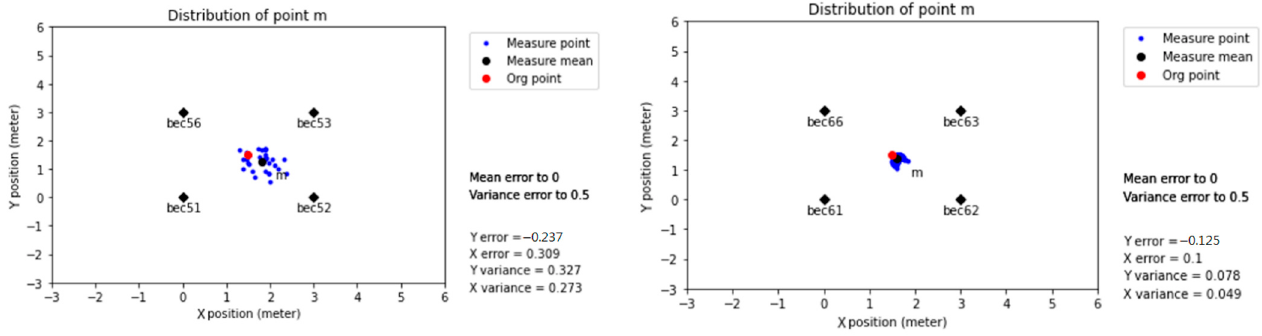
Figure 16. Intensive setup and predicted positioning.